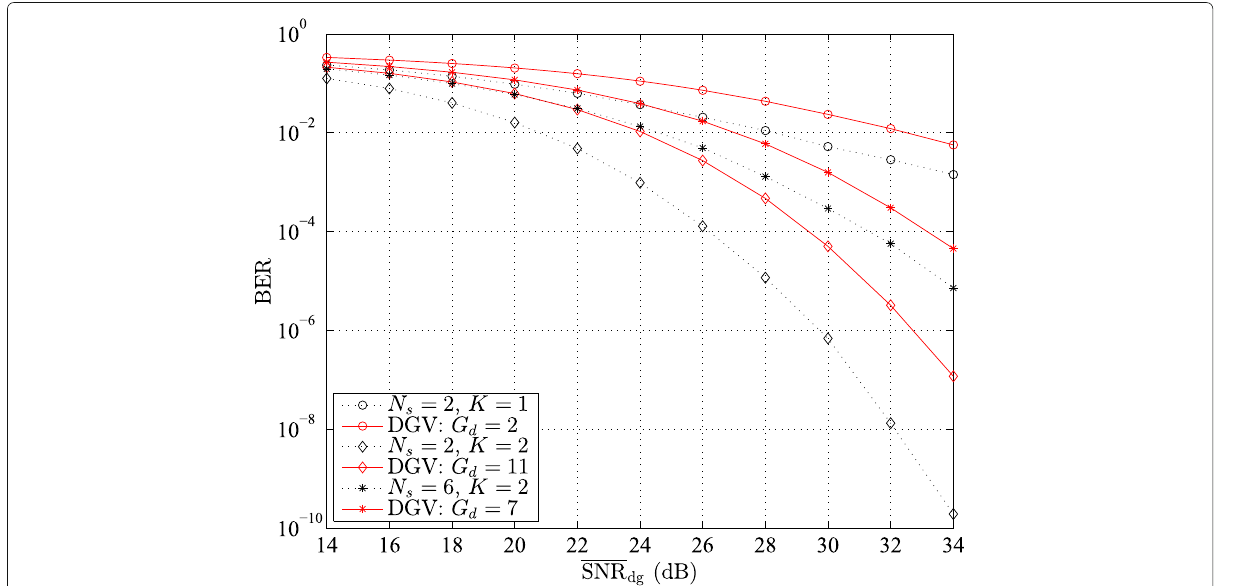
Fig. 6 BER versus designed SNR: verifying diversity gain